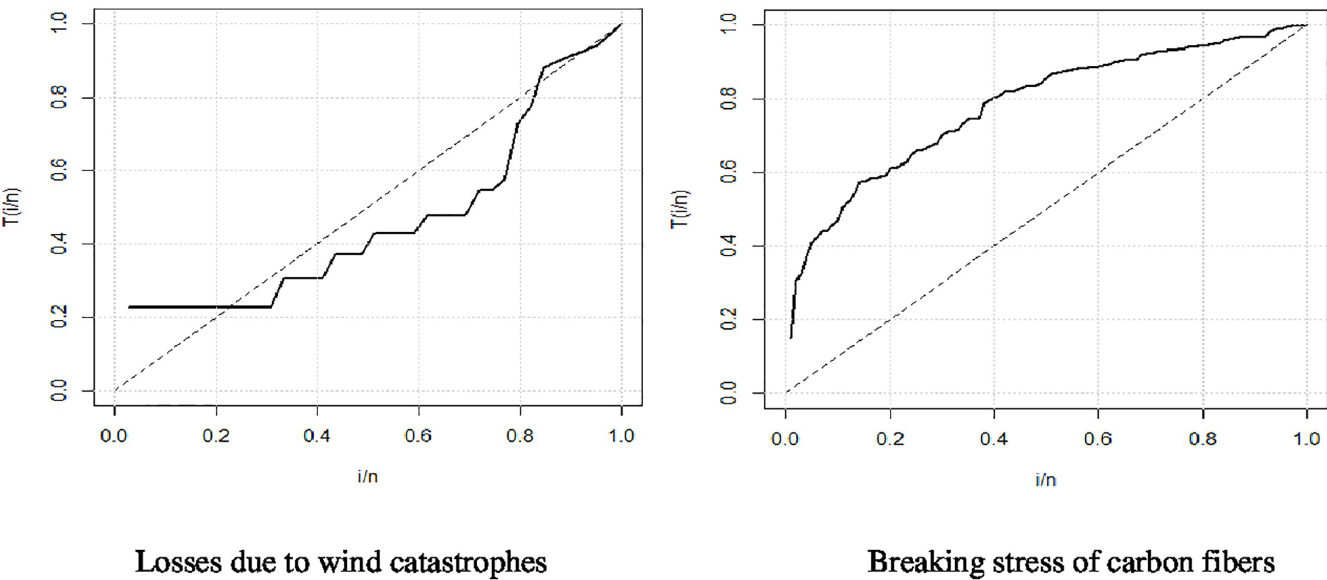
Fig 7. TTT plot for wind catastrophes and carbon